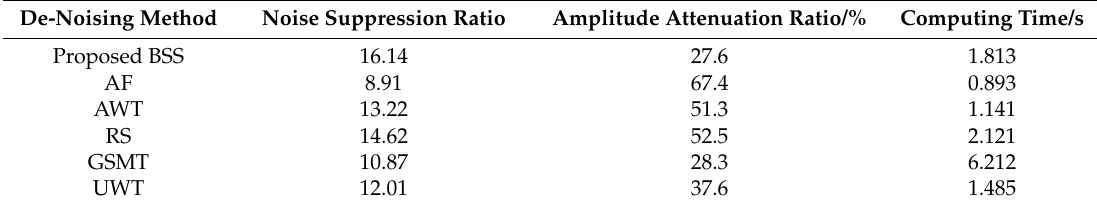
Table 4. De-noising performance evaluation results in field test.